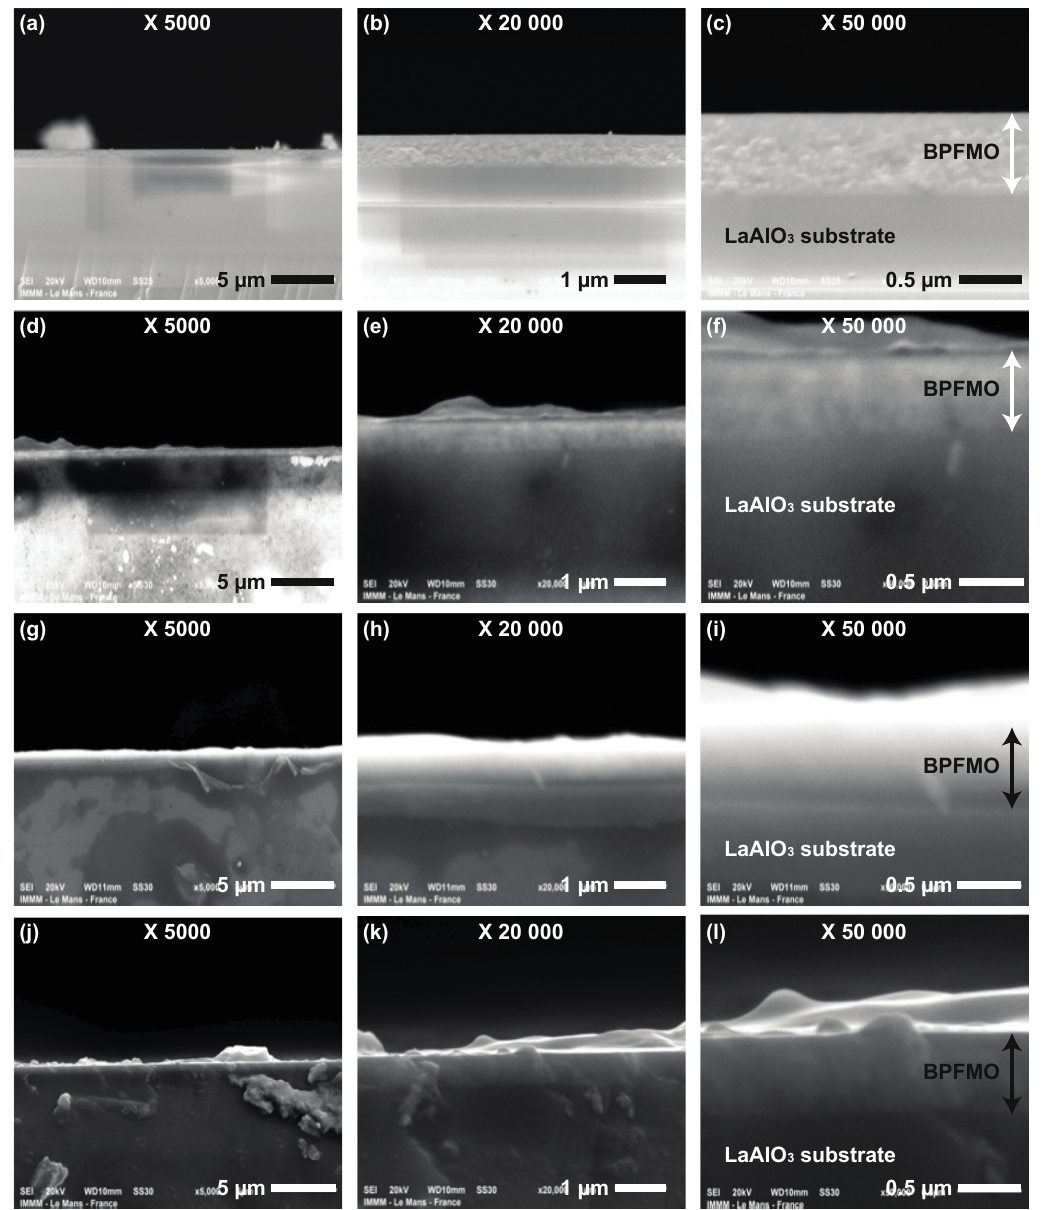
Figure A7. Side scanning electron microscope (SEM) images of the (Bi 1 − x Pr x )(Fe 0.95 Mn 0.05 )O 3 films deposited on LAO substrate for selected Pr substitution concentrations: ( a ) – ( c ) 5%, ( d ) – ( f ) 10%, ( g ) – ( i ) 12.5%, and ( j ) – ( l ) 20%.